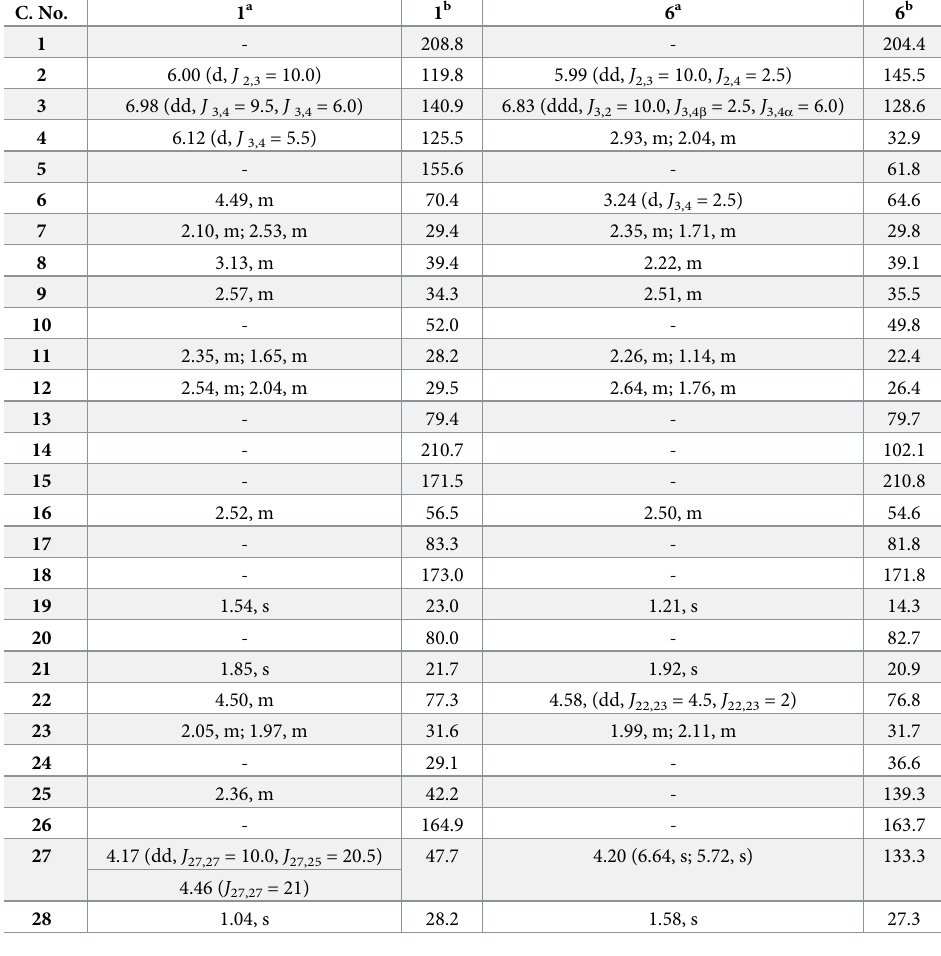
Table 1. 1 H-NMR and 13 C-NMR chemical shift data of compounds 1 and 6 ( δ in ppm, J in Hz). C.